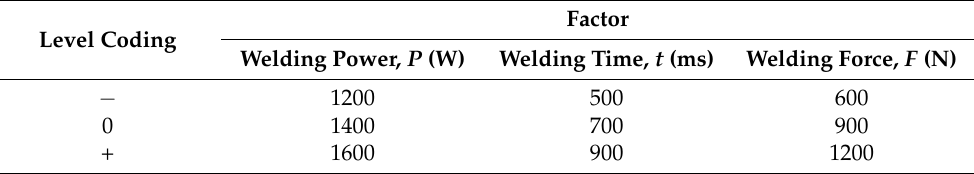
Table 1. Level codes and true values of the ultrasonic welding process parameters.